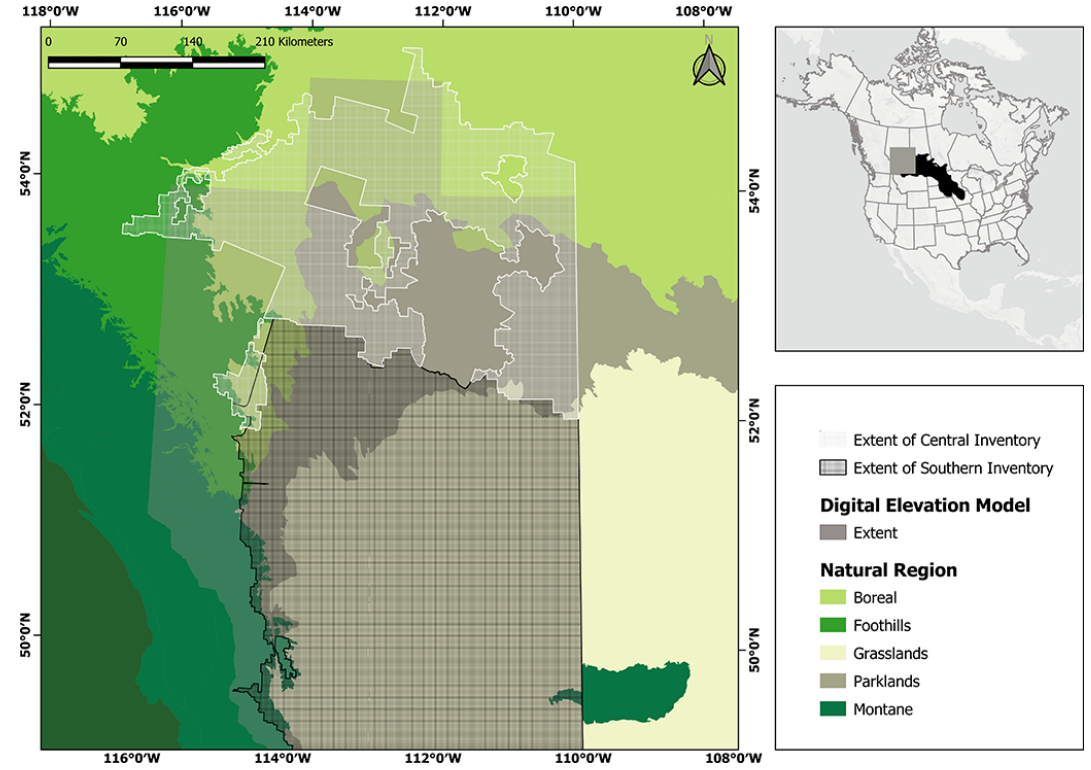
Figure 1. Extents of the Central and Southern wetland inventories (Government of Alberta, 2014) used to delineate wetlands in our study. We selected wetlands from three natural regions – Boreal Forest (120000), Parkland (120000) and Grassland (160000); natural region boundaries are sourced from the Government of Alberta (Government Alberta, 2016). These wetlands are within the southern Alberta Prairie Pothole Region. There are 356246 wetlands delineated in the Southern Inventory and 253873 in the Central Inventory. DEM data provided by AltaLIS